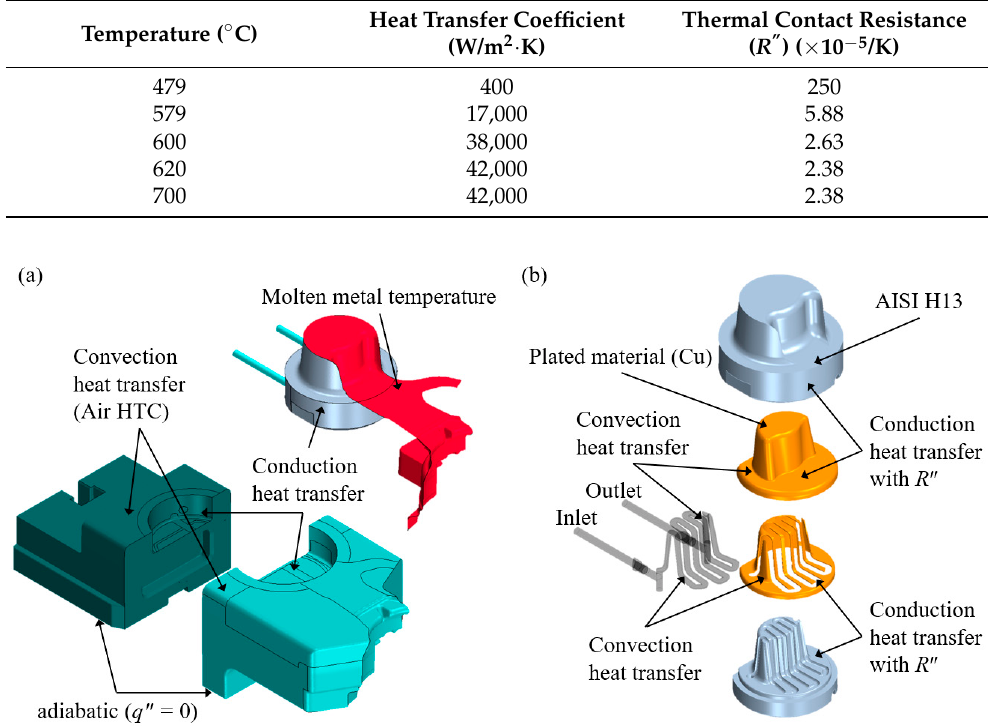
Figure 6. Thermal boundary conditions for thermofluid analysis. ( a ) Boundary conditions between the entire simulation domains. ( b ) Boundary conditions inside the combined different materials distributor (silver: AISI H13, yellow: Cu).